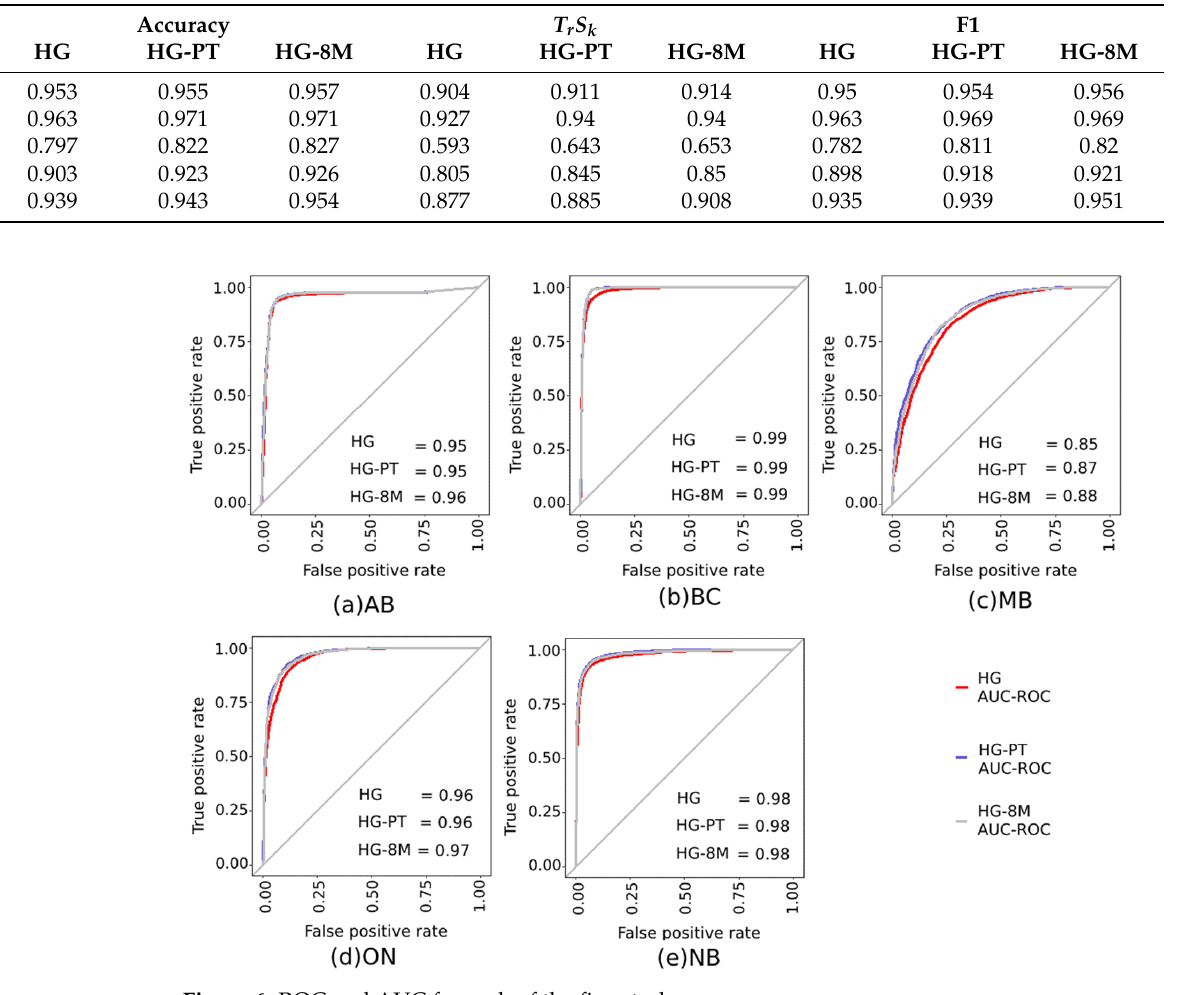
Figure 6. ROC and AUC for each of the five study areas.